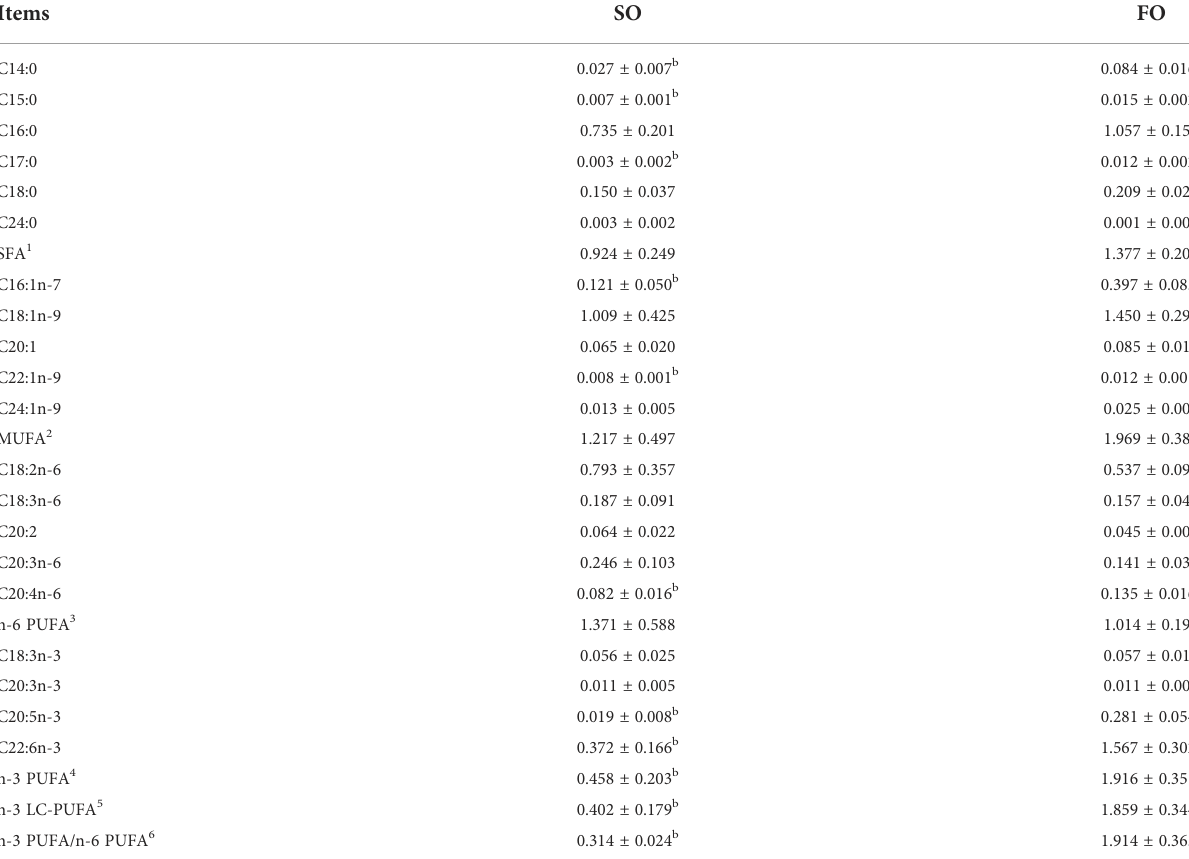
TABLE 2 Fatty acid composition in the ovary of the adult spotted scat fed with different types of oil sources (g/100g).